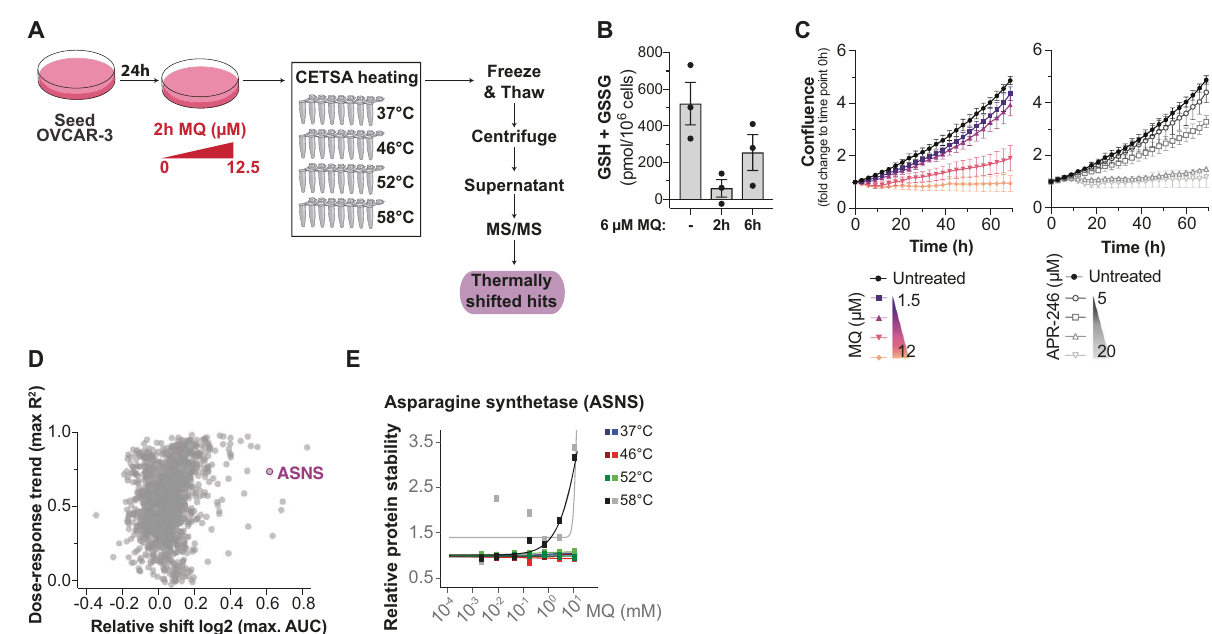
Fig. 1 MS-CETSA identi fi es asparagine synthetase (ASNS) as a putative MQ target. A Overview of experimental set-up for MQ treatment of OVCAR-3 cells and MS-CETSA 2 h after treatment. B Total glutathione (GSH + GSSG) measured by enzymatic recycling assay in OVCAR-3 cells after 2 or 6 h of 6 µM MQ treatment. Untreated control was harvested at the 6 h time point. n = 3. C Con fl uence of OVCAR-3 cells at the indicated MQ and APR-246 concentrations as assessed by Incucyte. Gradients indicate treatment concentrations of 1.5, 3, 6, and 12 µM MQ and 5, 7.5, 10, and 15 µM APR-246, respectively. n = 2 – 3 (except for 15 μ M where is n = 1). D Dot plot of the dose – response trend and relative shift of all thermally stabilized hits by MS-CETSA after MQ treatment in OVCAR-3 cells as shown in A . ASNS is indicated in purple. E MS-CETSA thermal shift response of ASNS with increasing concentrations of MQ at the indicated temperature in OVCAR-3 after 2 h of treatment. Different colors of the same temperature indicate separate MS runs. Relative protein stability is compared to vehicle control. MQ concentrations used were 0.0025, 0.01, 0.05, 0.2, 0.8, 3.1, and 12.5